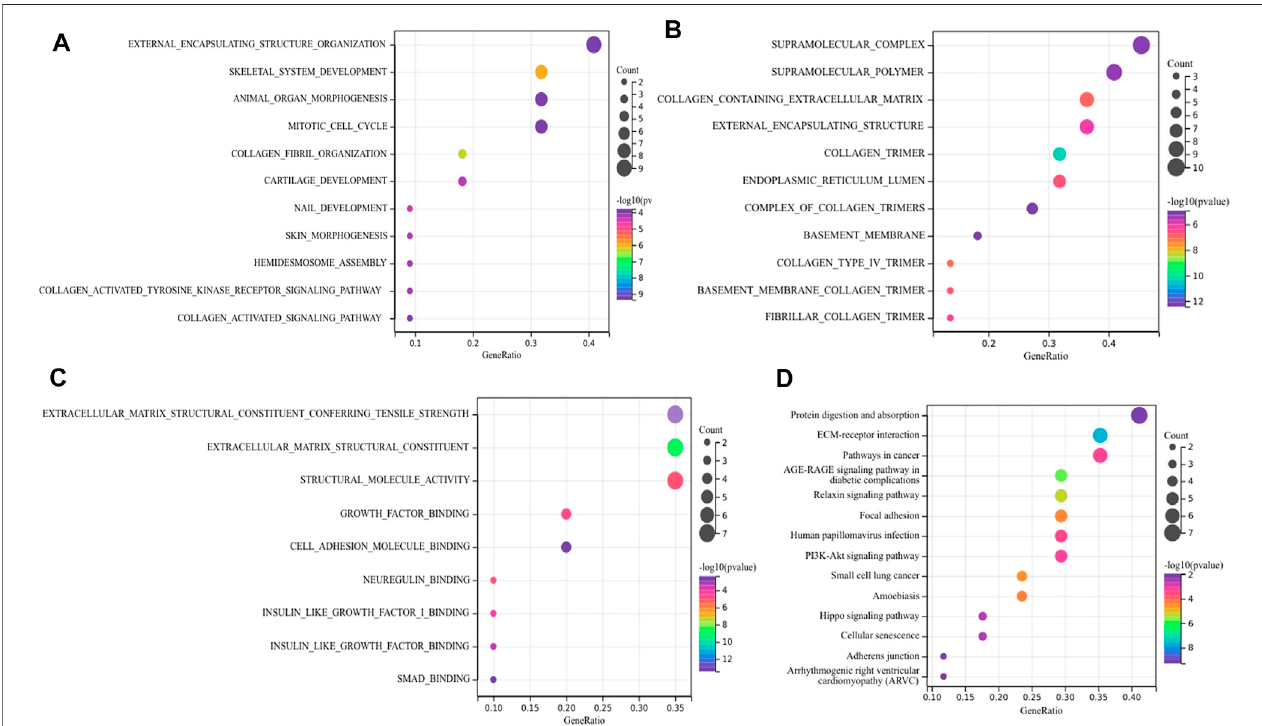
Frontiers in Bioengineering and Biotechnology |